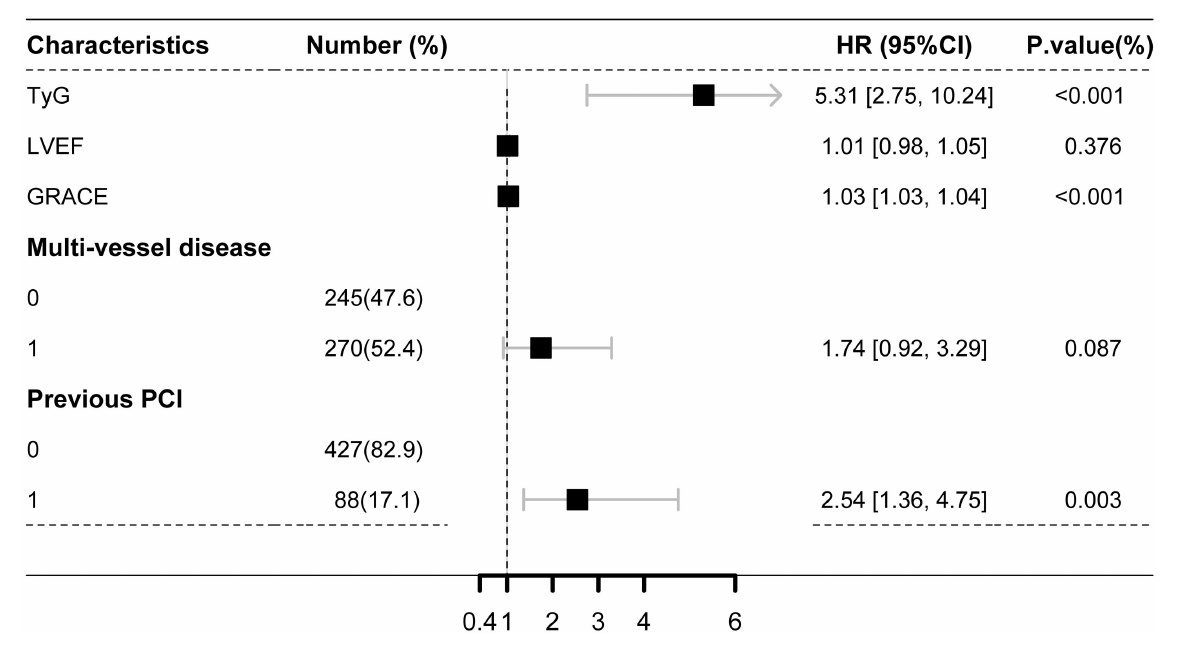
Patients were divided into two groups according to